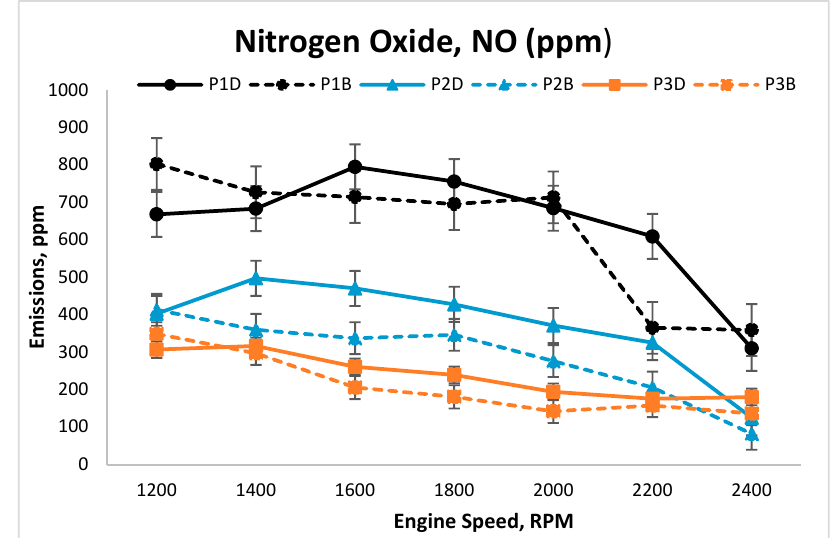
Figure 9. Nitrogen oxide (NO) emission at the variable speed.